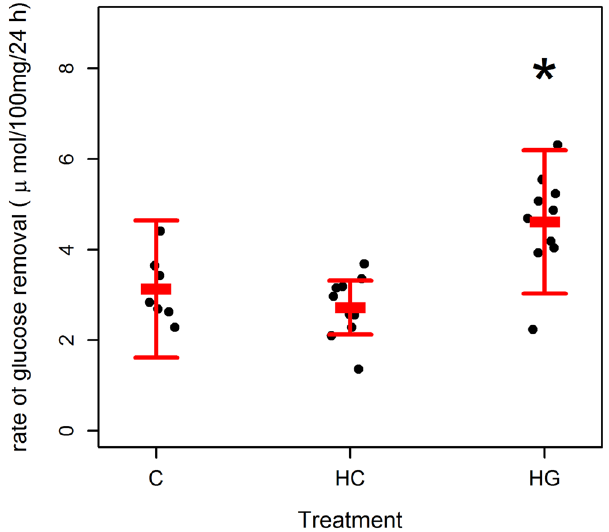
Figure 1. Effect of glucose and hydrocortisone on glucose removal from culture media by grey seal blubber explants. Glucose removal ( Δ glucose 24 h − 1 100 mg − 1 ) by 100 mg blubber tissue explants from grey seals (n = 10). Each point represents one animal. Bars represent mean ( ± s.d.). Tissues were minced and